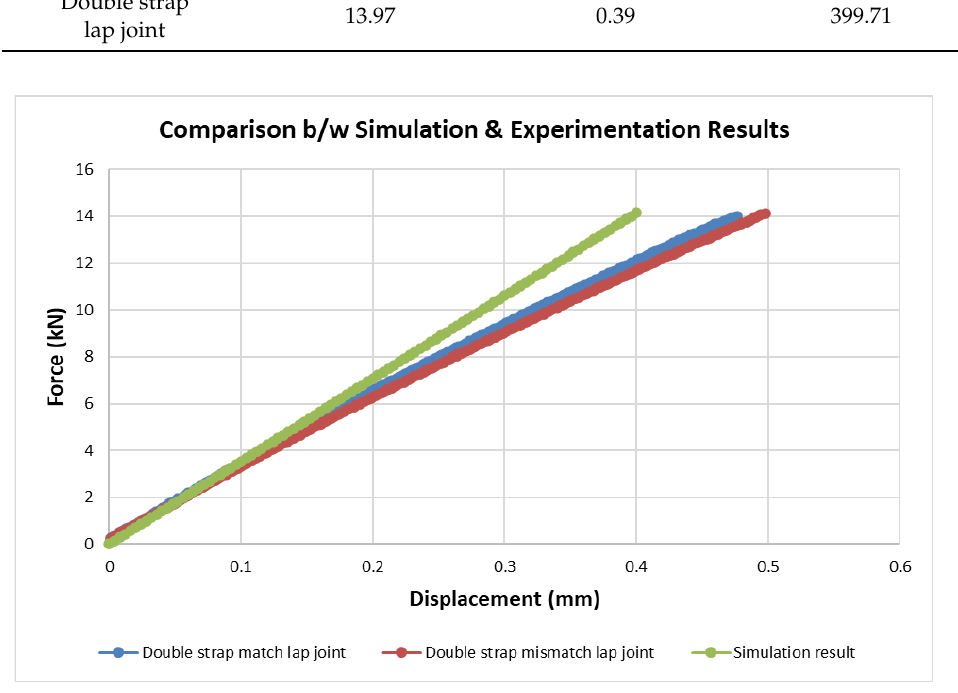
Figure 15. Comparison between simulation and experimental results.